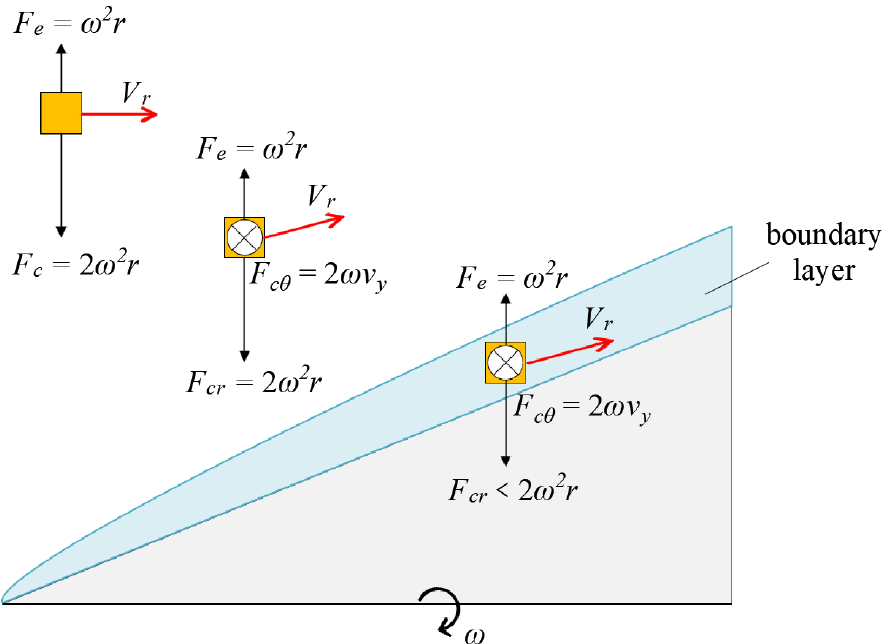
Figure 12. Force analysis of elemental volume . 𝐹 𝑒 is the centrifugal force, 𝐹 𝑐𝑟 is the radial Coriolis force, 𝐹 𝑐𝜃 is the circumferential Coriolis force.